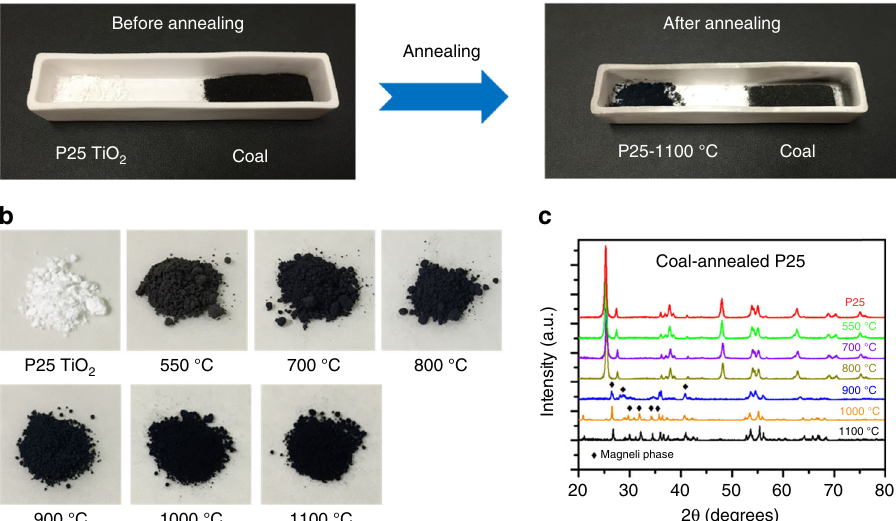
Fig. 4 Laboratory synthesis of Magnéli phases from TiO 2 under high temperature, low-oxygen conditions. a Synthesis of Magnéli Ti x O 2 x − 1 by annealing P25 TiO 2 nanoparticle with coal in a pure N 2 atmosphere. See text for details. b Photograph of different titanium oxides after annealing P25 TiO 2 nanoparticle with coal at different temperatures. c XRD patterns of coal-annealed P25 TiO 2 at different temperatures